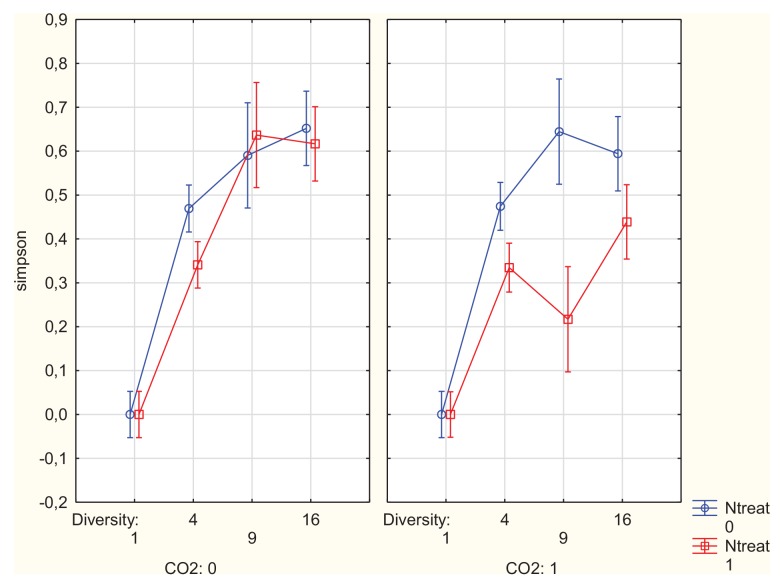
Plant species richness and N addition effects on Simpson evenness in the BioCON experiment.For statistical results see main text. Means with 95% confidence intervals.